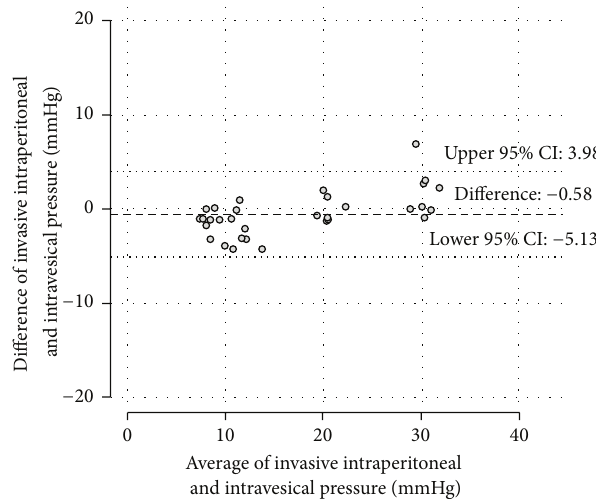
Figure 2: The Bland-Altman diagram plots the differences against the averages of simultaneous IAP measurements from the intraves- ical probes and the invasive piezoresistive probe values. No obvious signs of an increasing inaccuracy with rising values are